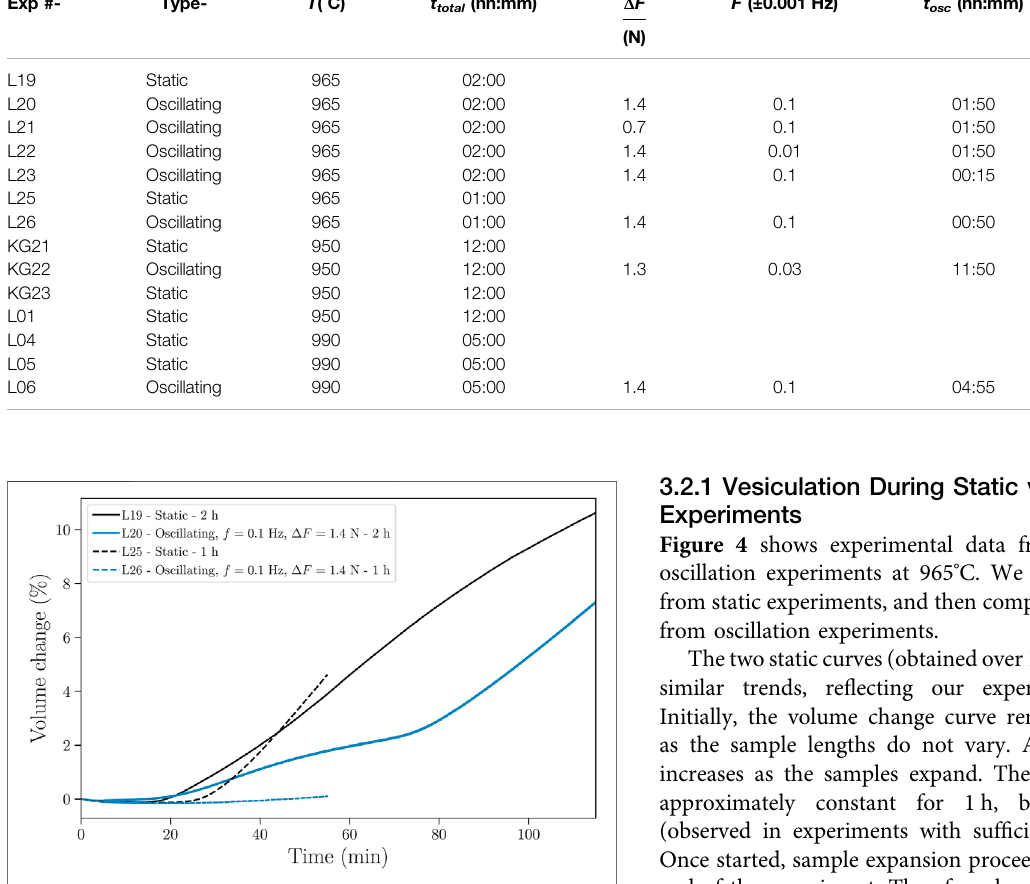
FIGURE 4 | Volume change as a function of time for four experiments at 965 ° C, two static (black) and two oscillating (blue). Time is set to zero 5 min aftertheisothermisreached(theheatingphaseisnotshown).Theuncertainty on the volume change is smaller than the line